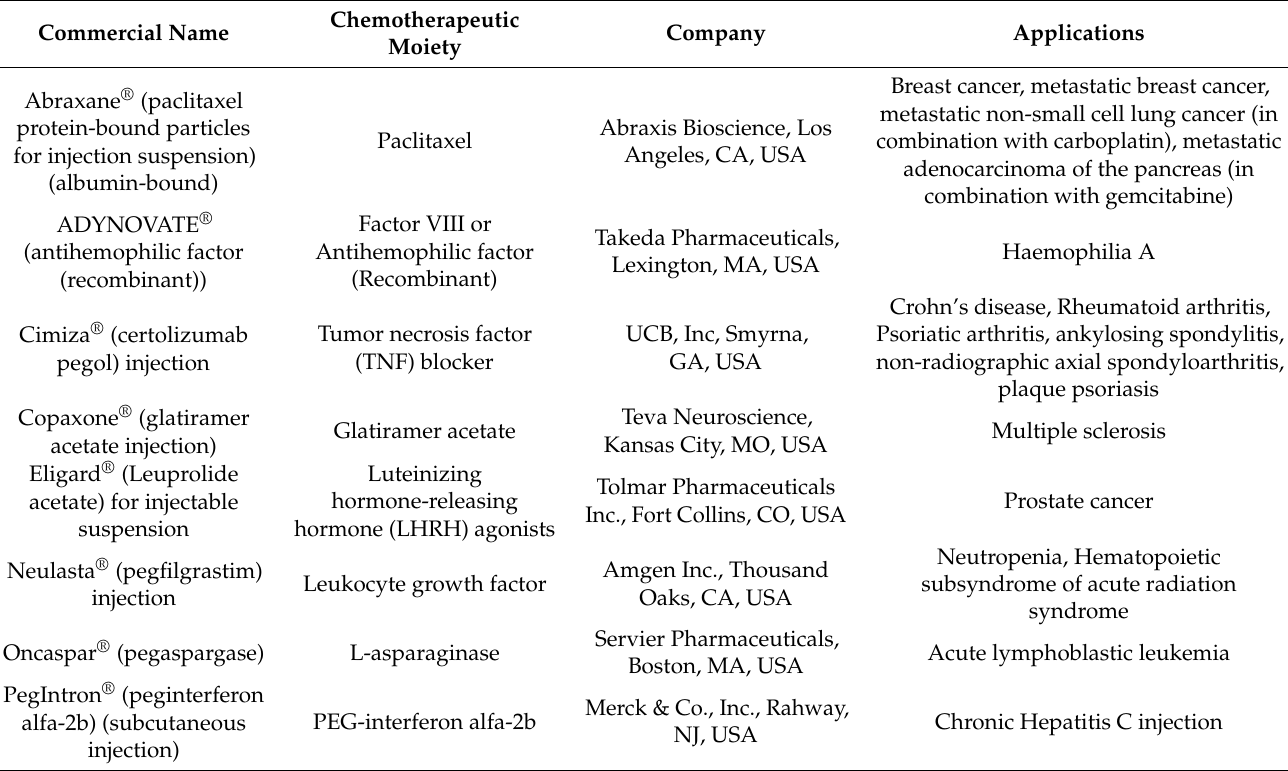
Table 1. FDA-approved commercial polymeric-based